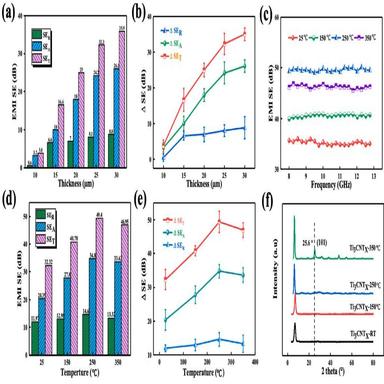
(a) EMI SET, SER, and SEA of Ti3CNTx coatings with different thicknesses. (b) ΔSET, ΔSER, and ΔSEA of Ti3CNTx coatings with different thicknesses. (c) EMI shielding measurements of Ti3CNTx coatings at different annealing temperatures. (d) EMI SET, SER, and SEA of Ti3CNTx coatings at different annealing temperatures. (e) ΔSET, ΔSER, and ΔSEA of Ti3CNTx coatings at different annealing temperatures. (f) The XRD patterns of MXene coatings at different annealing temperatures.